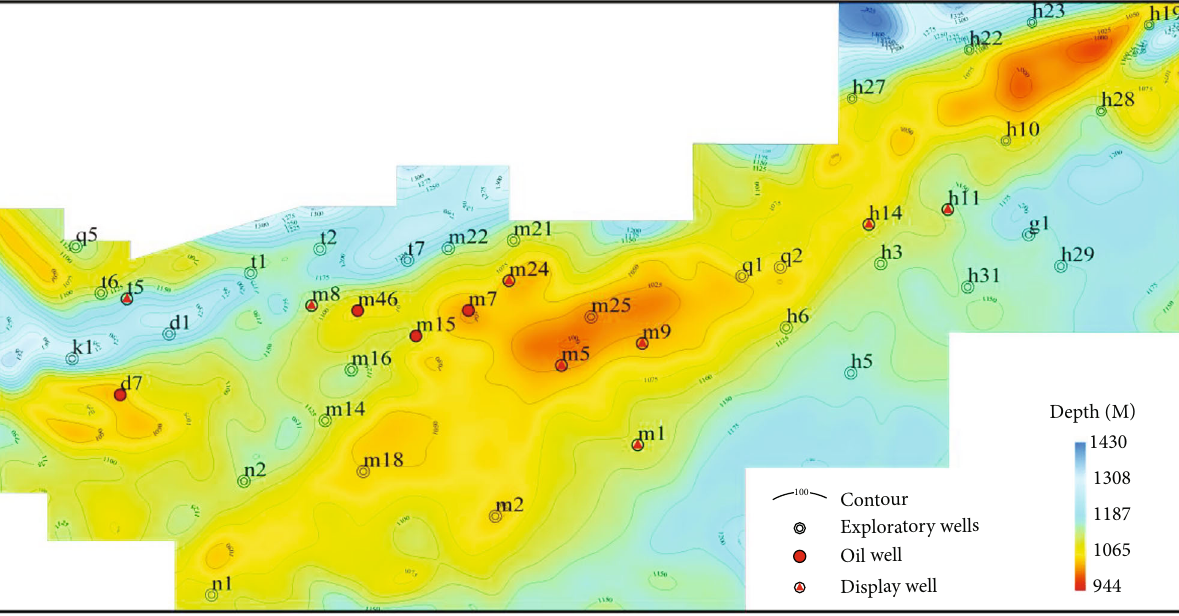
Figure 14: Cretaceous paleostructures before deposition of the Kuqa Formation in the western Tabei